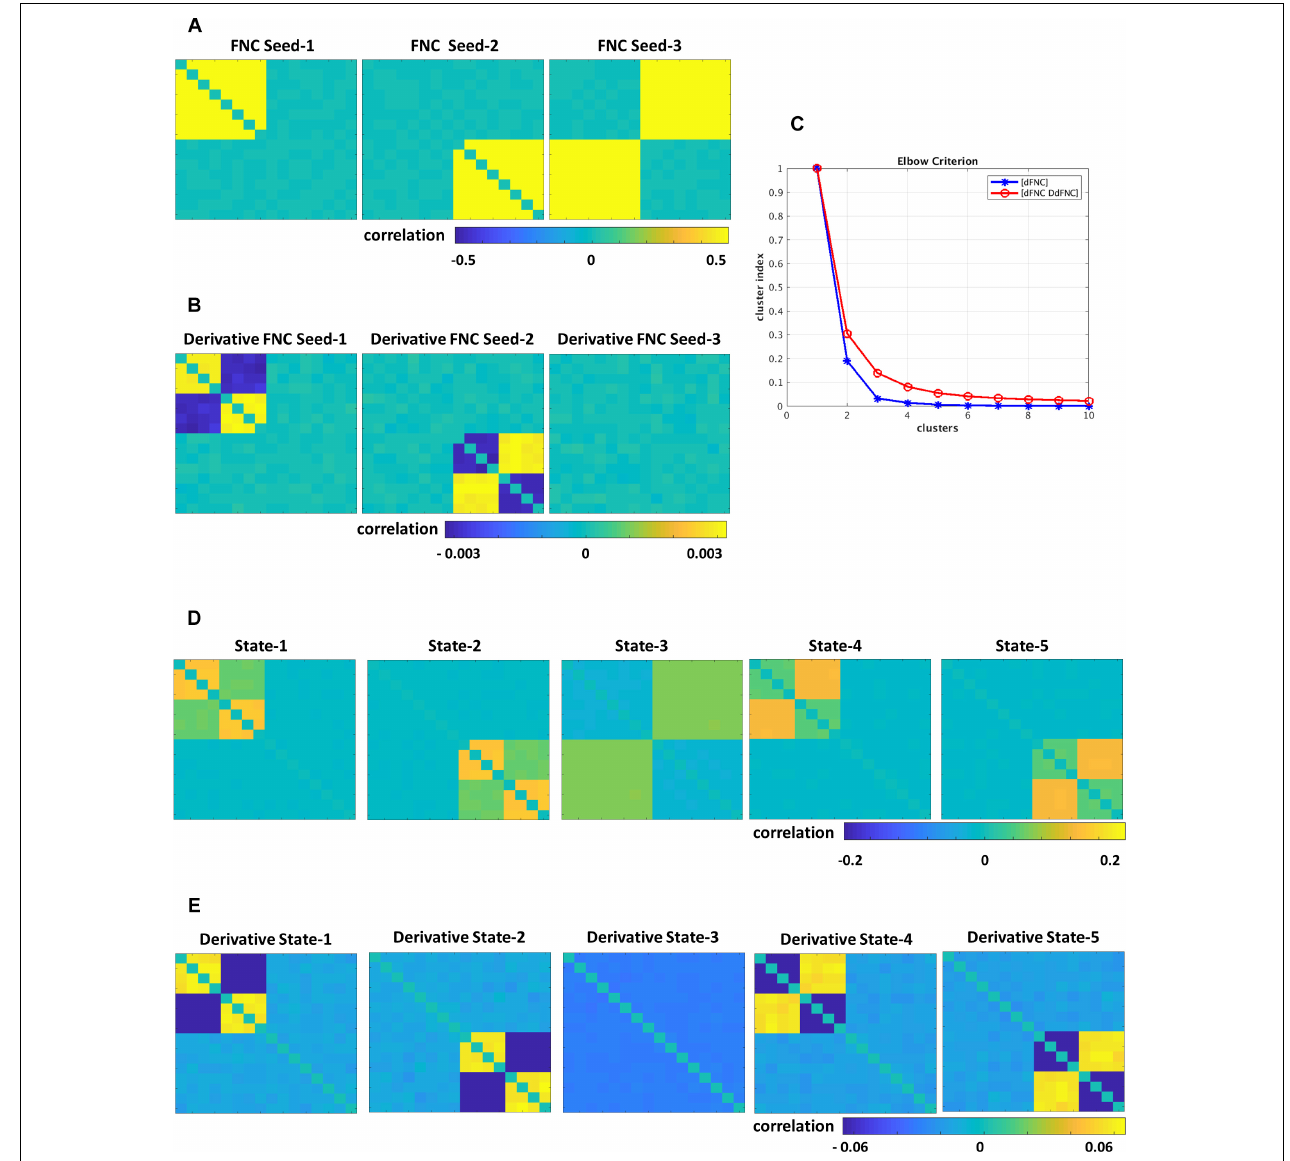
FIGURE 2 | Simulated data, (A) FNC seeds, (B) derivatives of FNC seeds, (C) Elbow criterion results for dFNC and tvFNC methods, panels (D,E) show FNC states and their derivatives choosing optimal number of clusters =